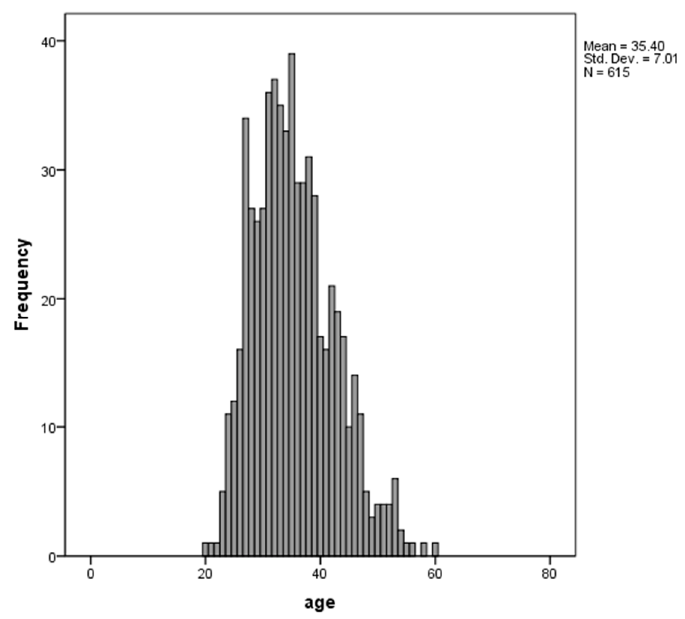
Figure 1. Histogram and descriptive statistics of participants age (in months).